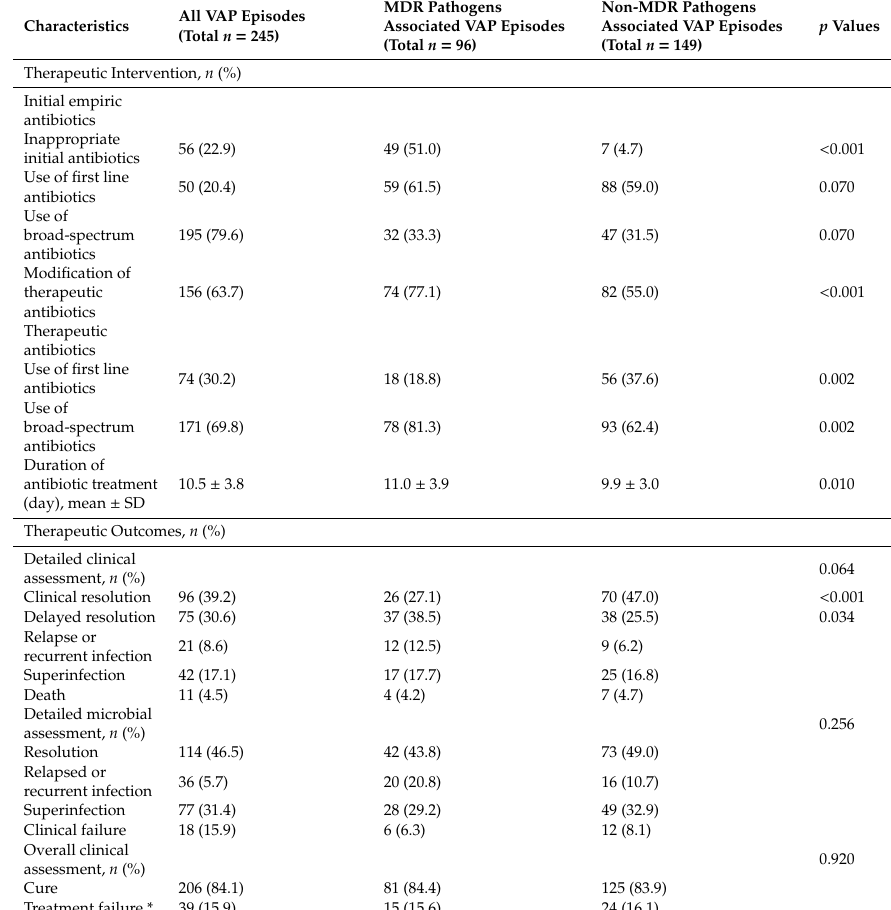
Table 3. Therapeutic intervention and outcomes of all neonatal ventilator-associated pneumonia (VAP) at CGMH, October 2017 to March